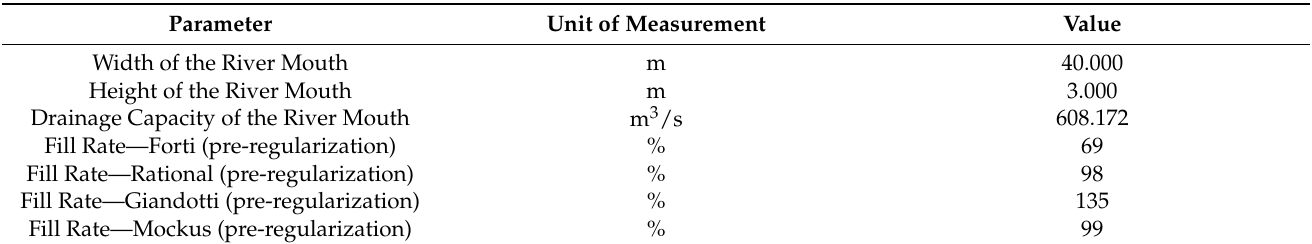
Table 6. Assessment of the need for detention basin